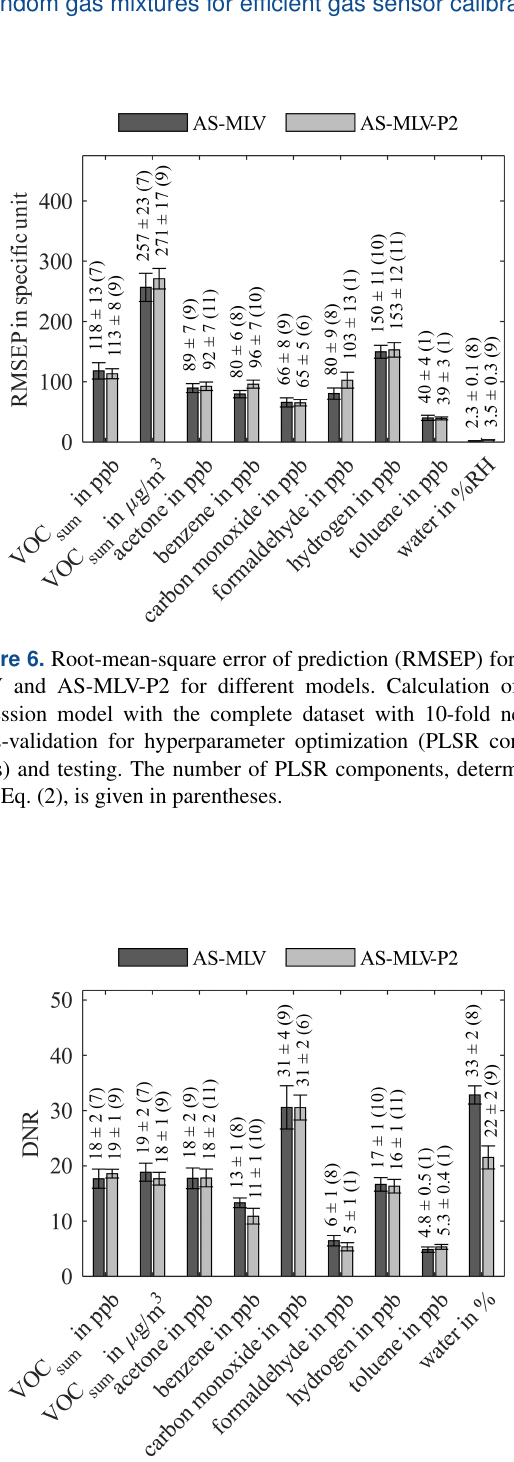
Figure 7. Dynamic range (DNR) for AS-MLV and AS-MLV-P2 for different models. Calculation of the regression model with the complete dataset with 10-fold nested cross-validation for hyperpa- rameter optimization (PLSR components) and testing. The number of PLSR components, determined with Eq. (2), is given in paren-